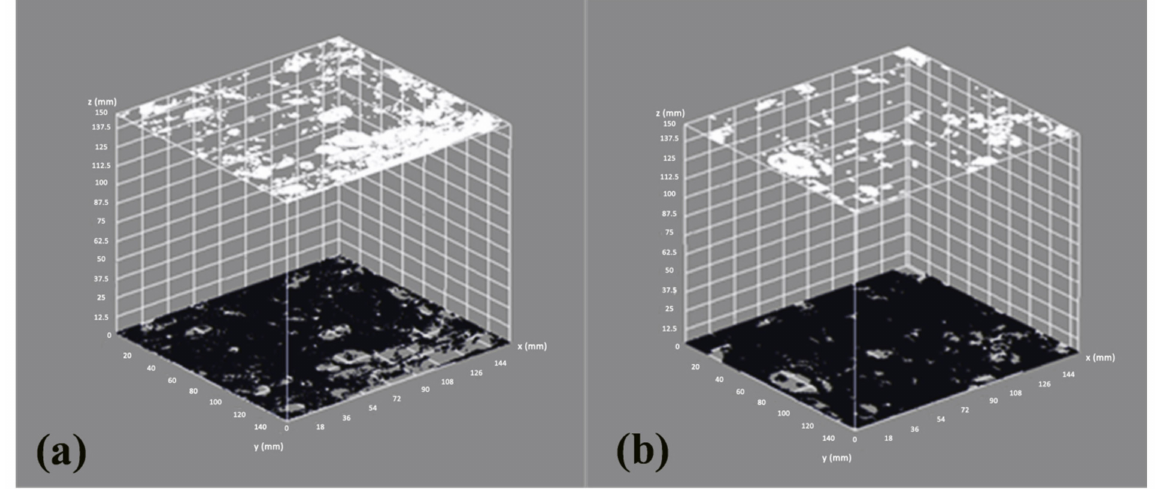
Figure 8. Pore structures of ( a ) SCC control and ( b ) 35SSS-C. Indicating in white the pores and in black the solid